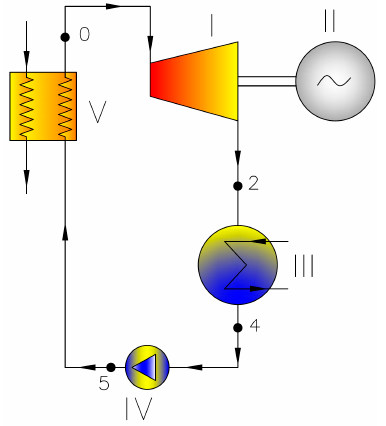
Figure 1. Standard Organic Rankine Cycle (ORC) cycle for wet fluids; where: I—turbine, II—generator, III—condenser, IV—main pump, V—vapor generator.